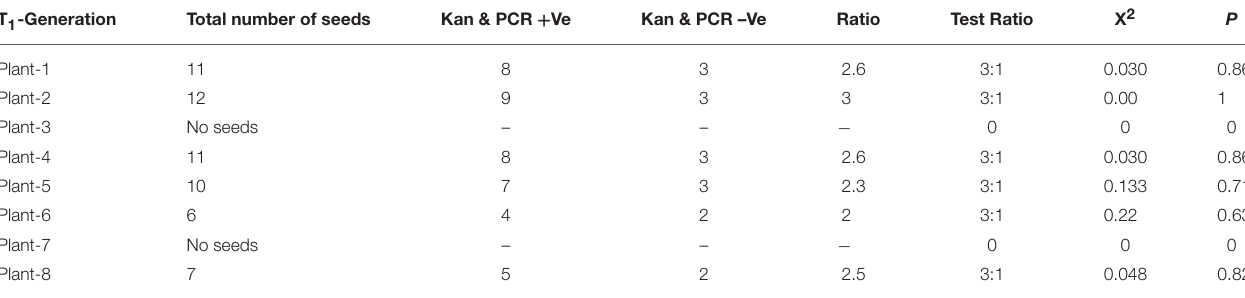
TABLE 1 | Segregation analysis of AtHDG11 gene in self progenies (T1) derived from AtHDG11 transgenic plants. T 1